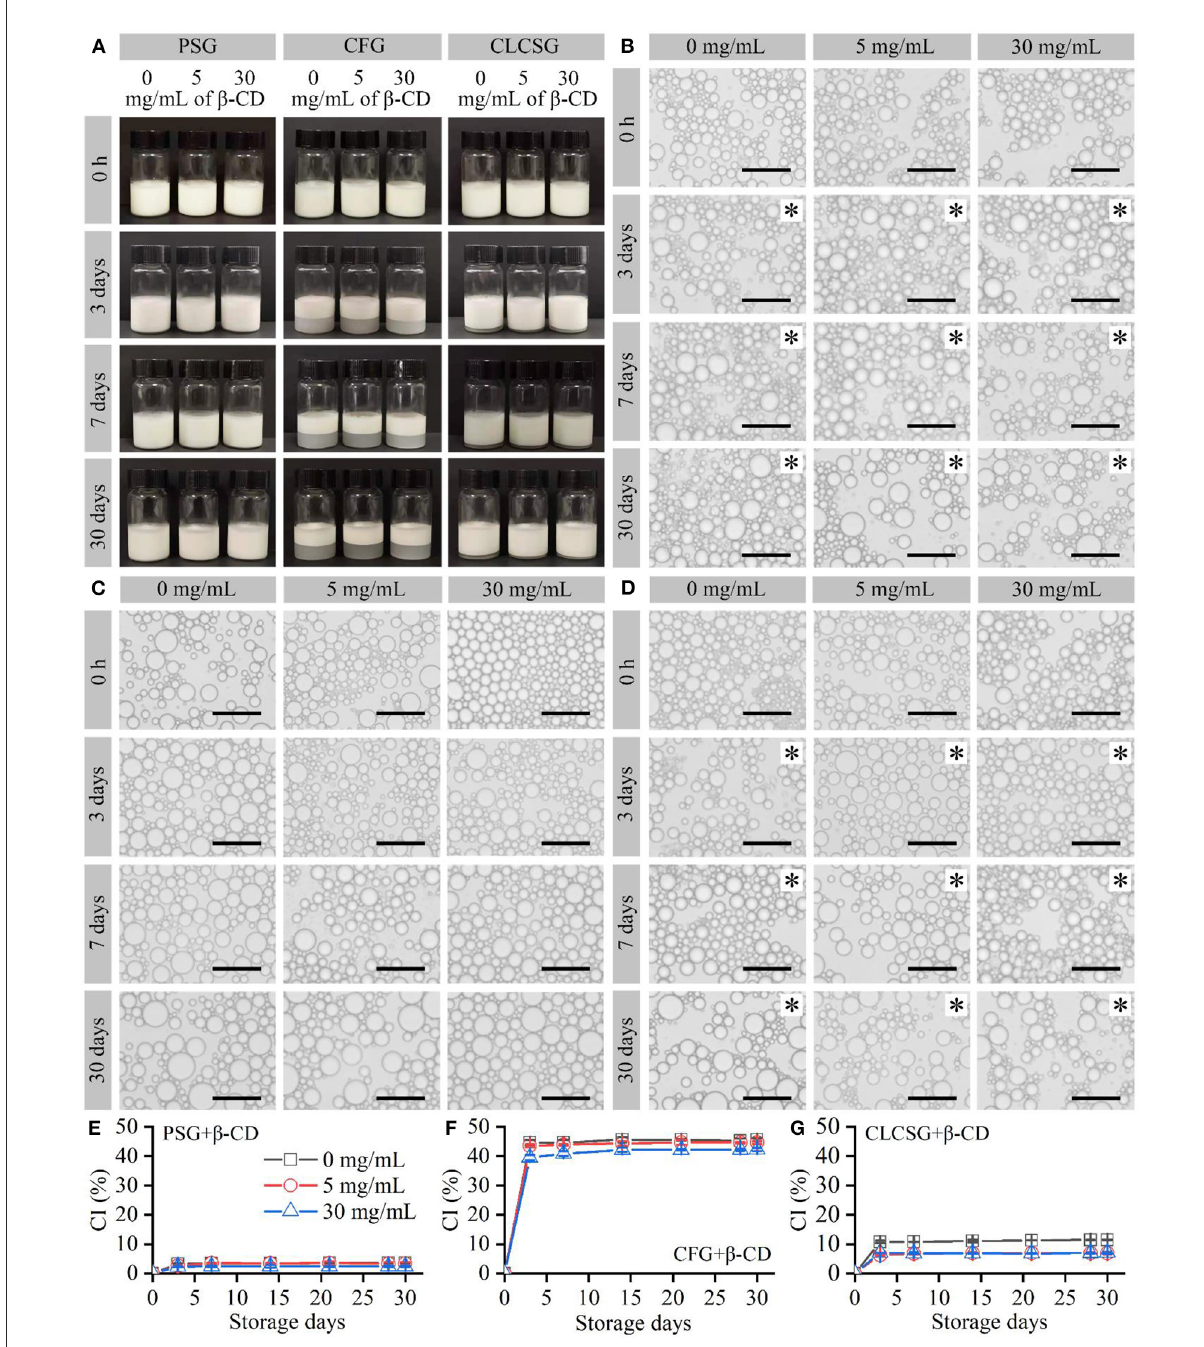
FIGURE2 Preparation and storage (4 ◦ C) of fish oil-loaded emulsions stabilized by gelatins with β -CD. (A) Digital camera images of the emulsions. (B–D) Optical microscopy images of the emulsion droplets stabilized by PSG, CFG, and CLCSG, respectively, with β -CD. Black asterisks indicate emulsion gels. Scale bars indicate 50 µ m. (E–G) Creaming index (CI) values of the emulsions.